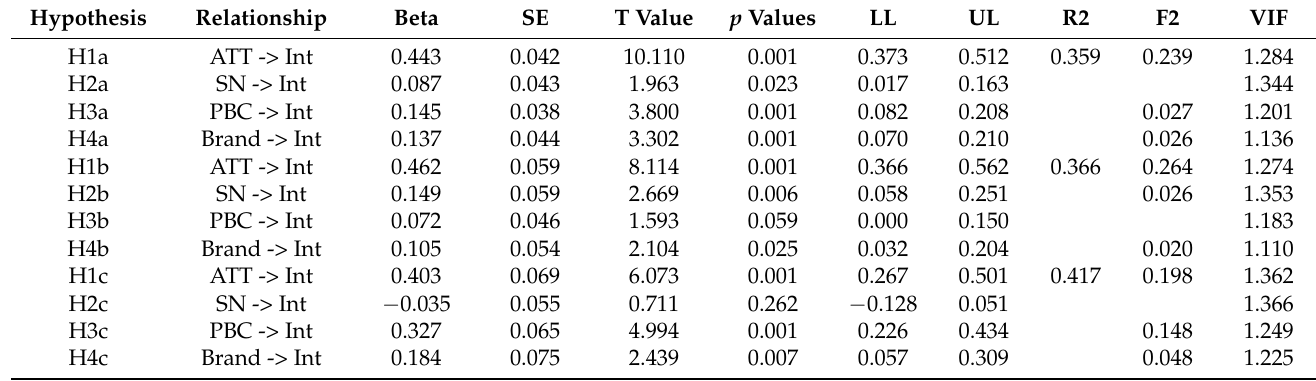
Table 5. Hypotheses